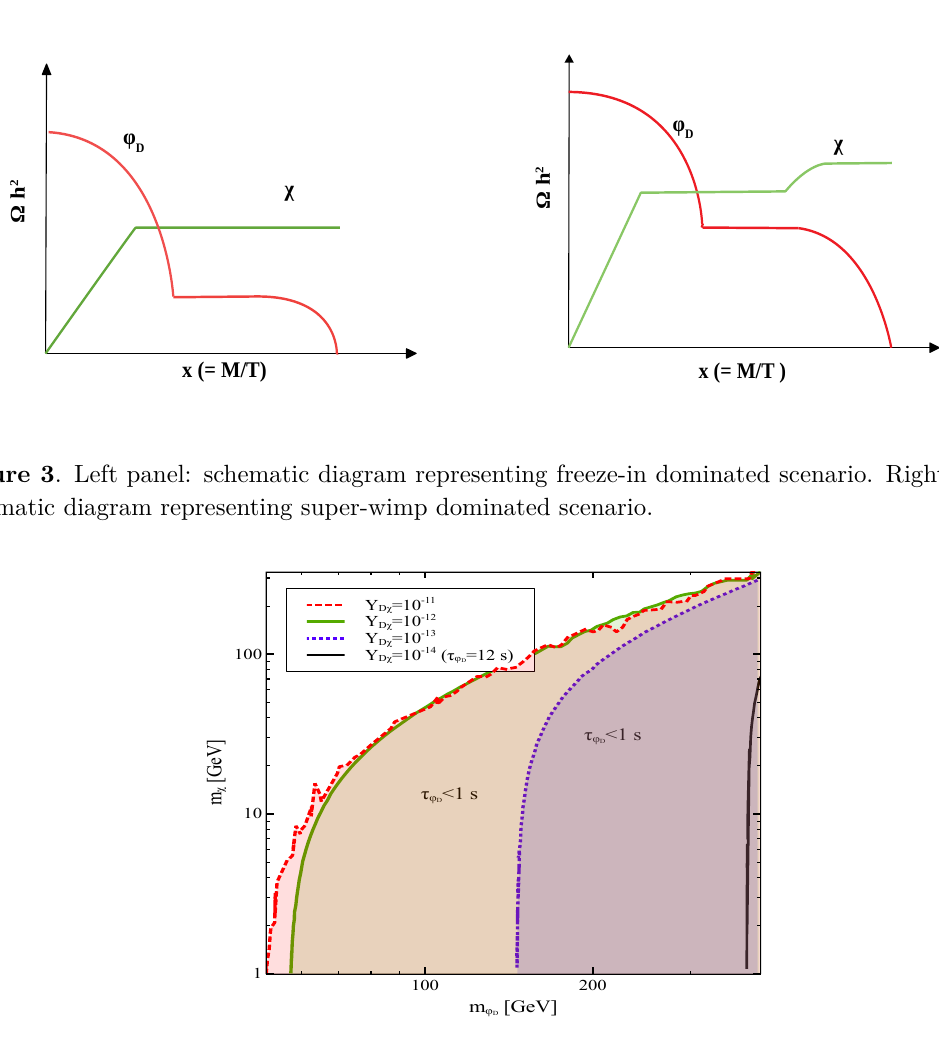
. For Dχ is less than D